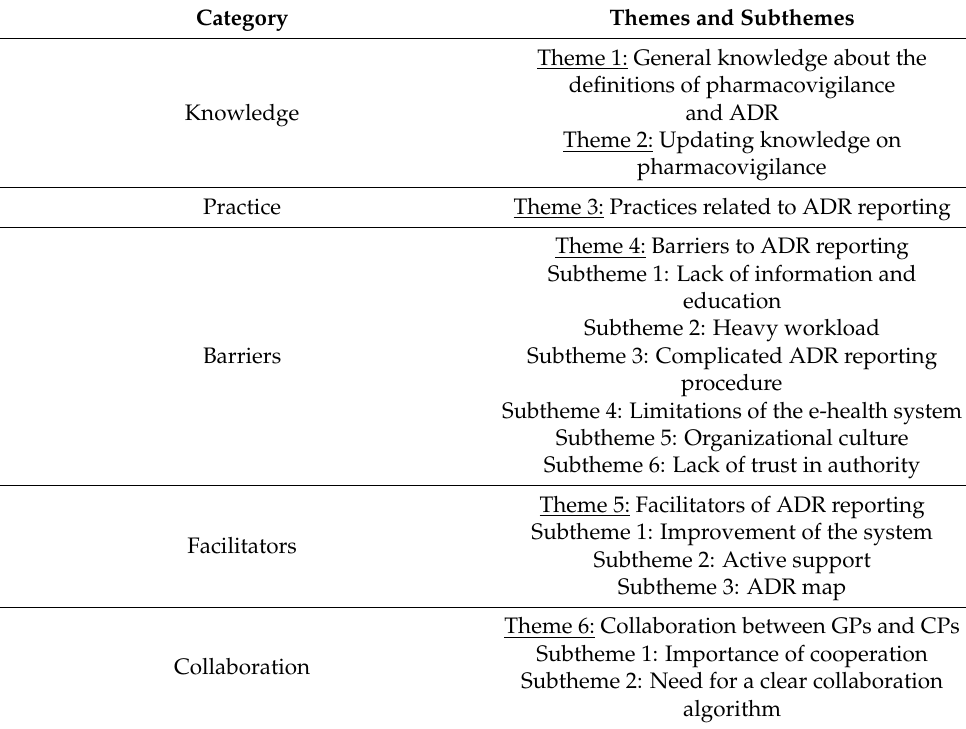
Table 2. Description of themes and